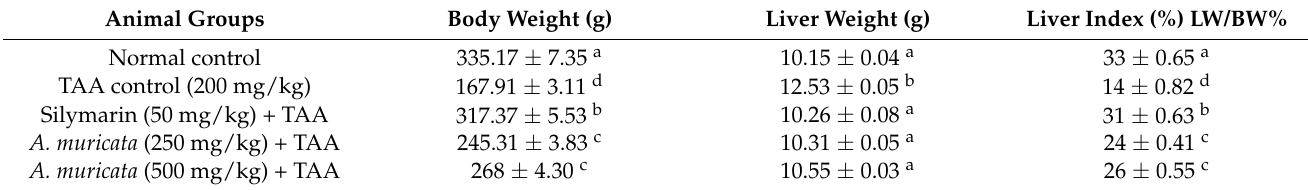
injury in rats after 2